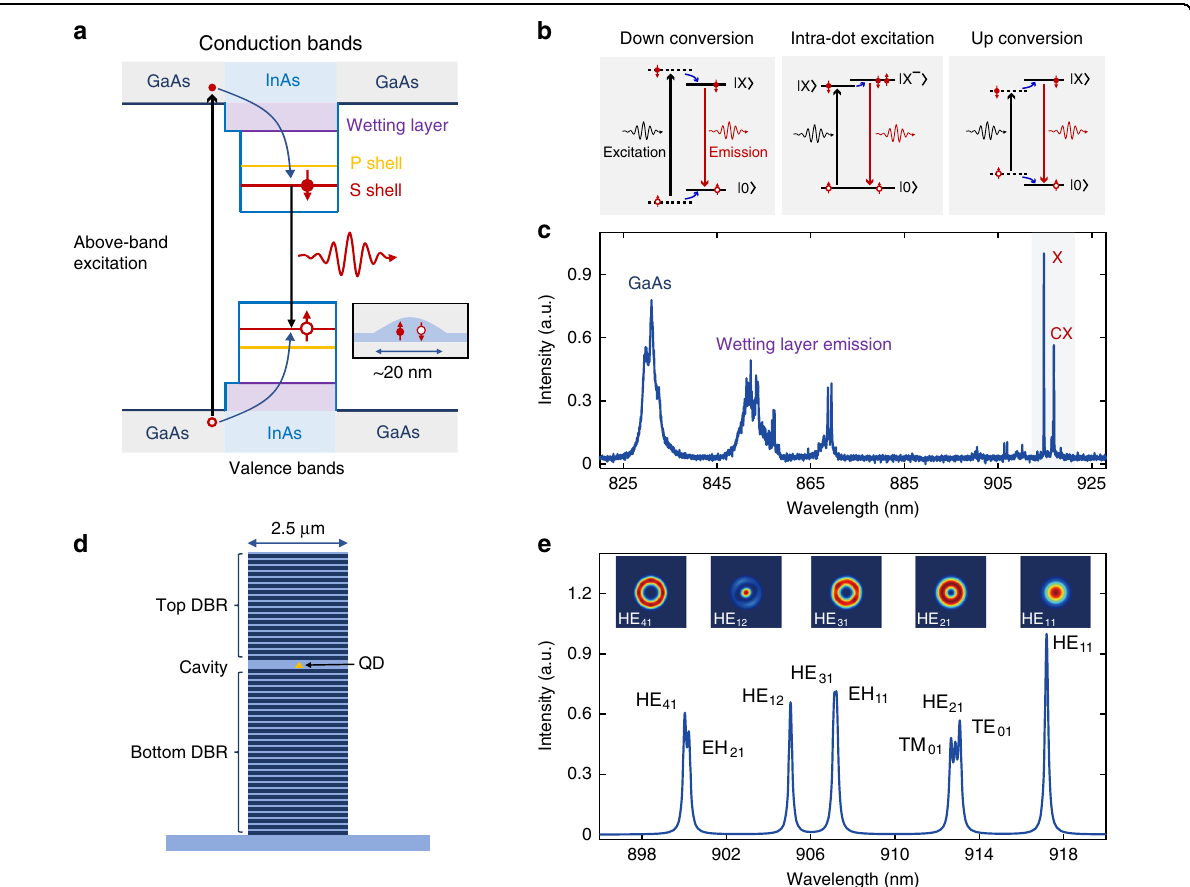
Fig. 1 QD-micropillar system. a Schematic of the energy diagram of InAs QD embedded in GaAs matrix. The quantum con fi nement of carriers in the QD results in discrete energy levels. b Different excitation schemes for triggering the single-photon emissions from exciton states in QDs used in the work. All the excitation methods can be improved by the optical resonances provided from microcavities. The black and red lines represent the optical excitation and photon emission processes respectively while the blue lines denote the non-radiative process. c Representative spectrum of a single QD under the low-power above-band excitation. d Schematic of the coupled QD-micropillar system. e The calculated radiation spectrum and the mode pro fi les of the micropillar cavity with a diameter of 2.5 μ